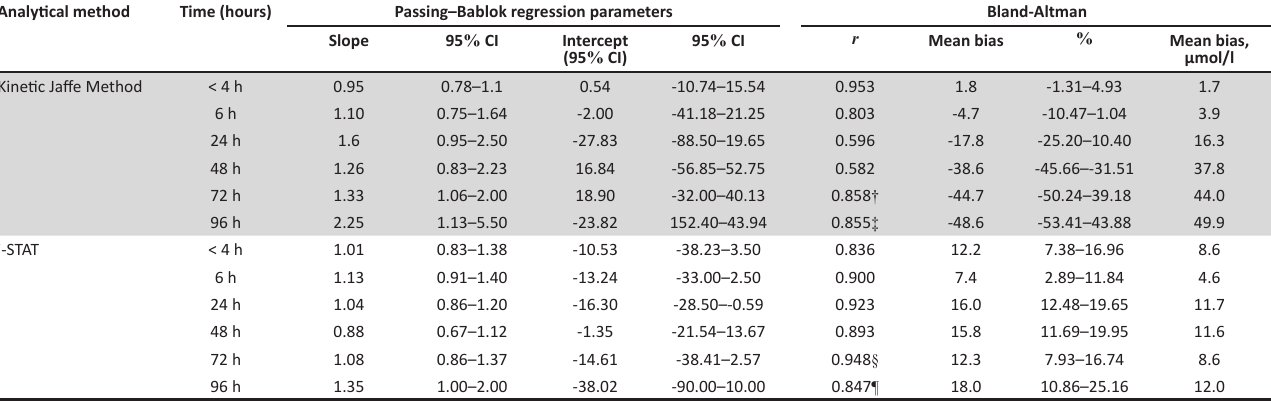
TABLE 2: Comparison of serum creatinine levels from kinetic Jaffe method and i-STAT method to the enzymatic method using Passing-Bablok and Bland-Altman analysis. Analytical method Time